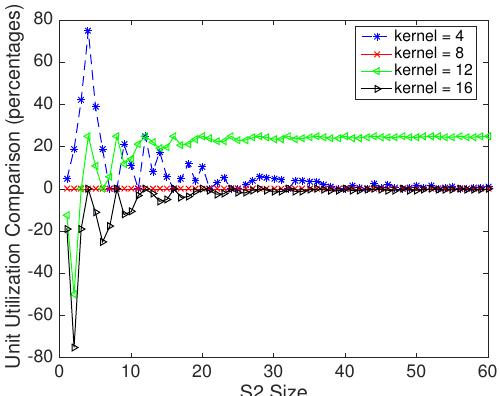
Figure 9. Unit utilization improvement compared to CoRe16 under different kernels. In most cases (except for kernel = 12), SAFA unit utilization is close or better than CoRe16.